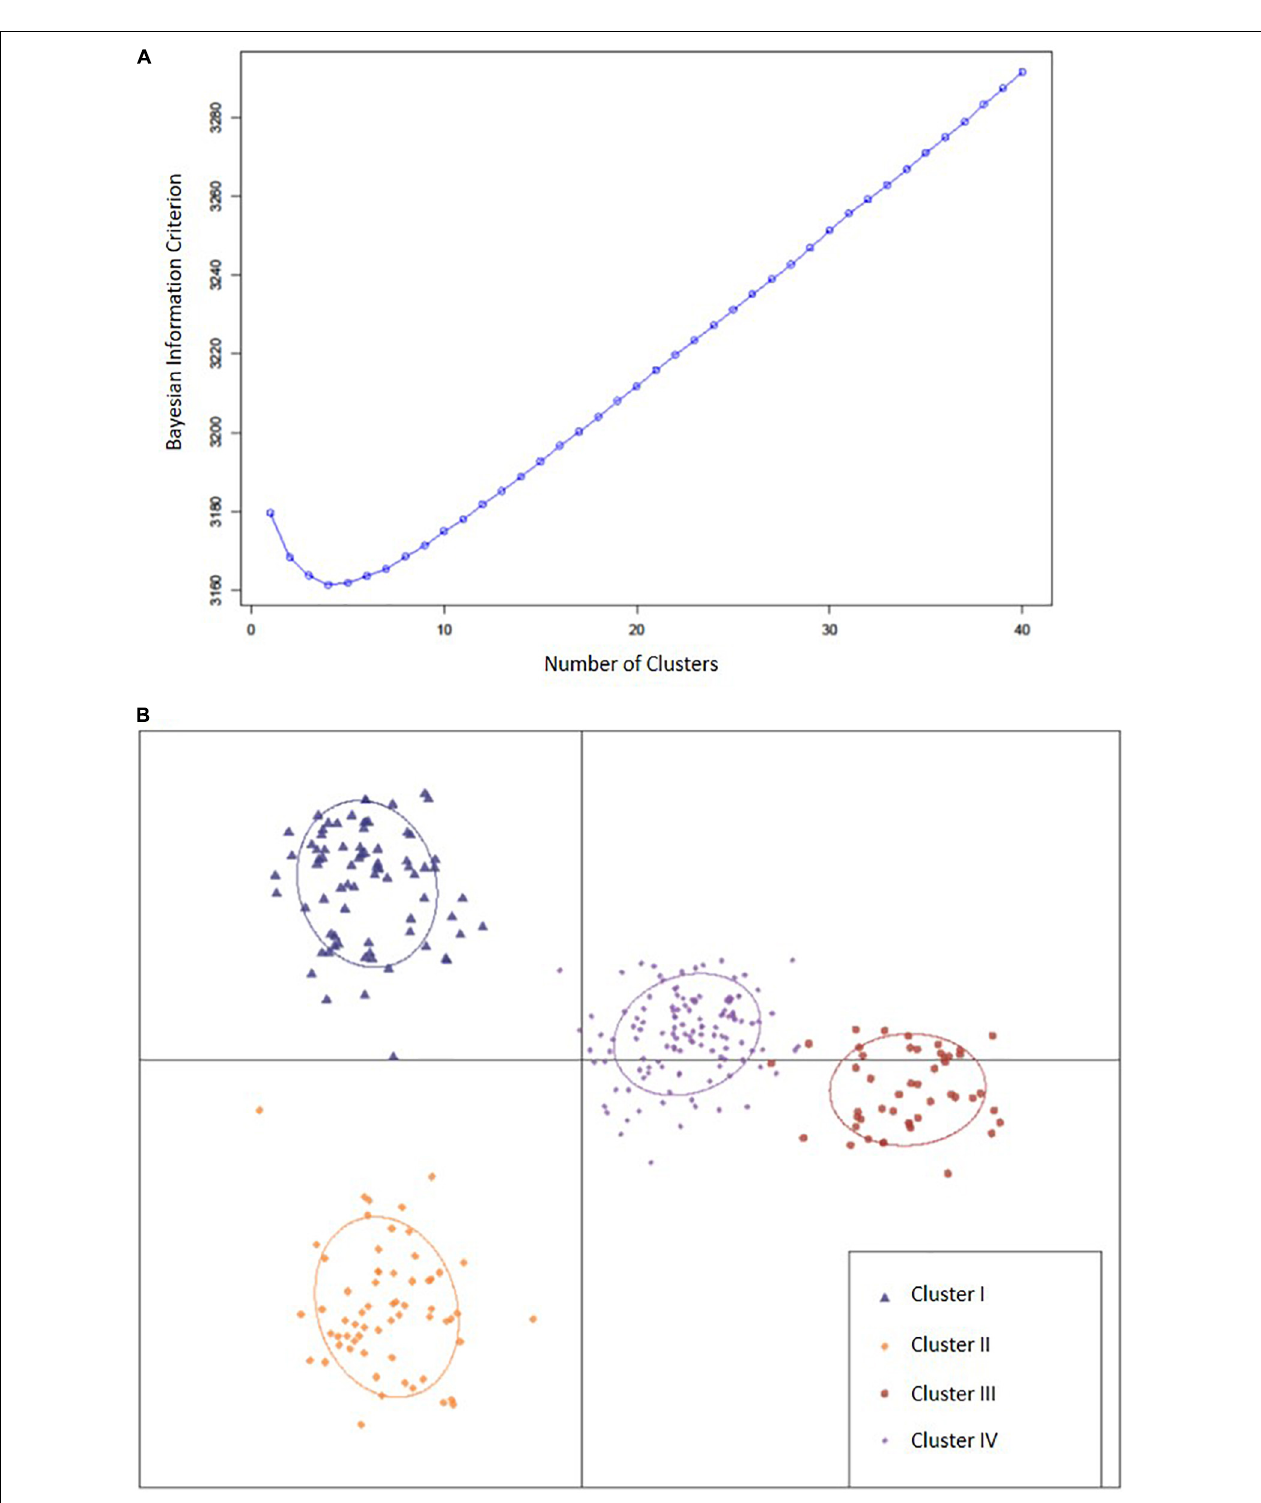
FIGURE 2 | (A) Bayesian information criterion for selecting the optimal number of clusters. (B) A scatter plot depicting the four clusters ( k = 4) identified as likely subpopulations within the 311 accessions: cluster I (blue triangle, n = 76), cluster II (gold diamonds, n = 62), cluster III (large red circles, n = 47), cluster IV (small purple circles, n =